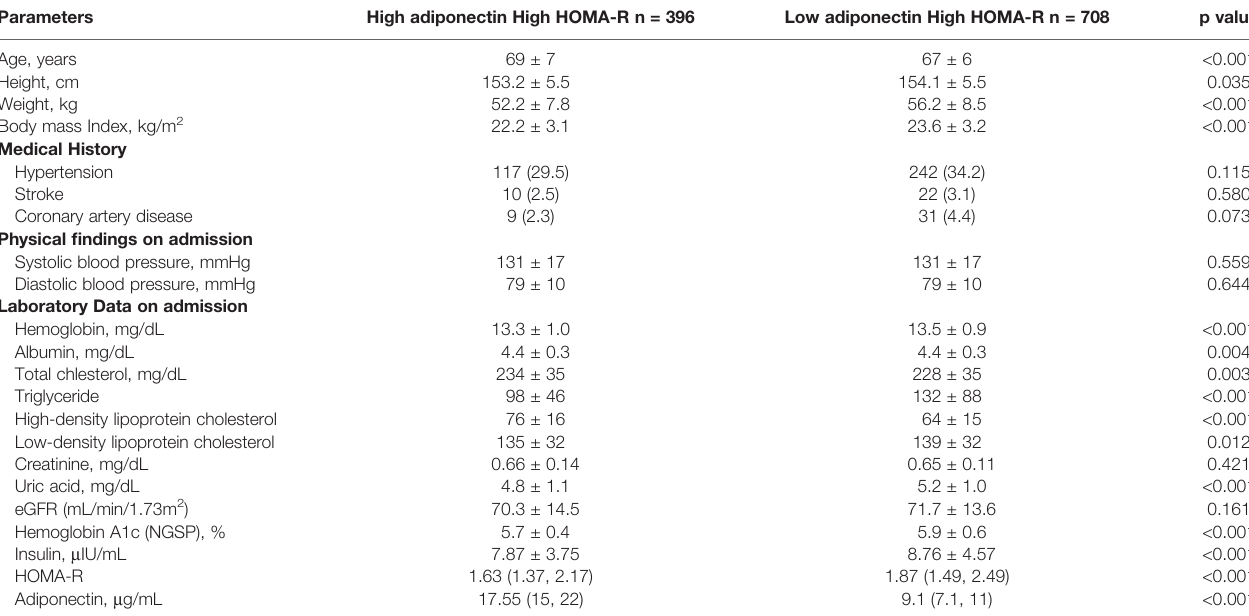
TABLE 2B | Clinical and biological characteristics of high HOMA-R 1,104 females strati fi ed by H-adiponectin/H-HOMA and H-adiponectin/L-HOMA. Parameters High adiponectin High HOMA-R n = 396 Low adiponectin High HOMA-R n =